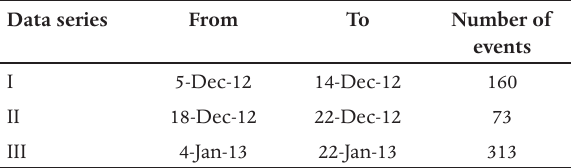
Table 4. Data series of the monitoring